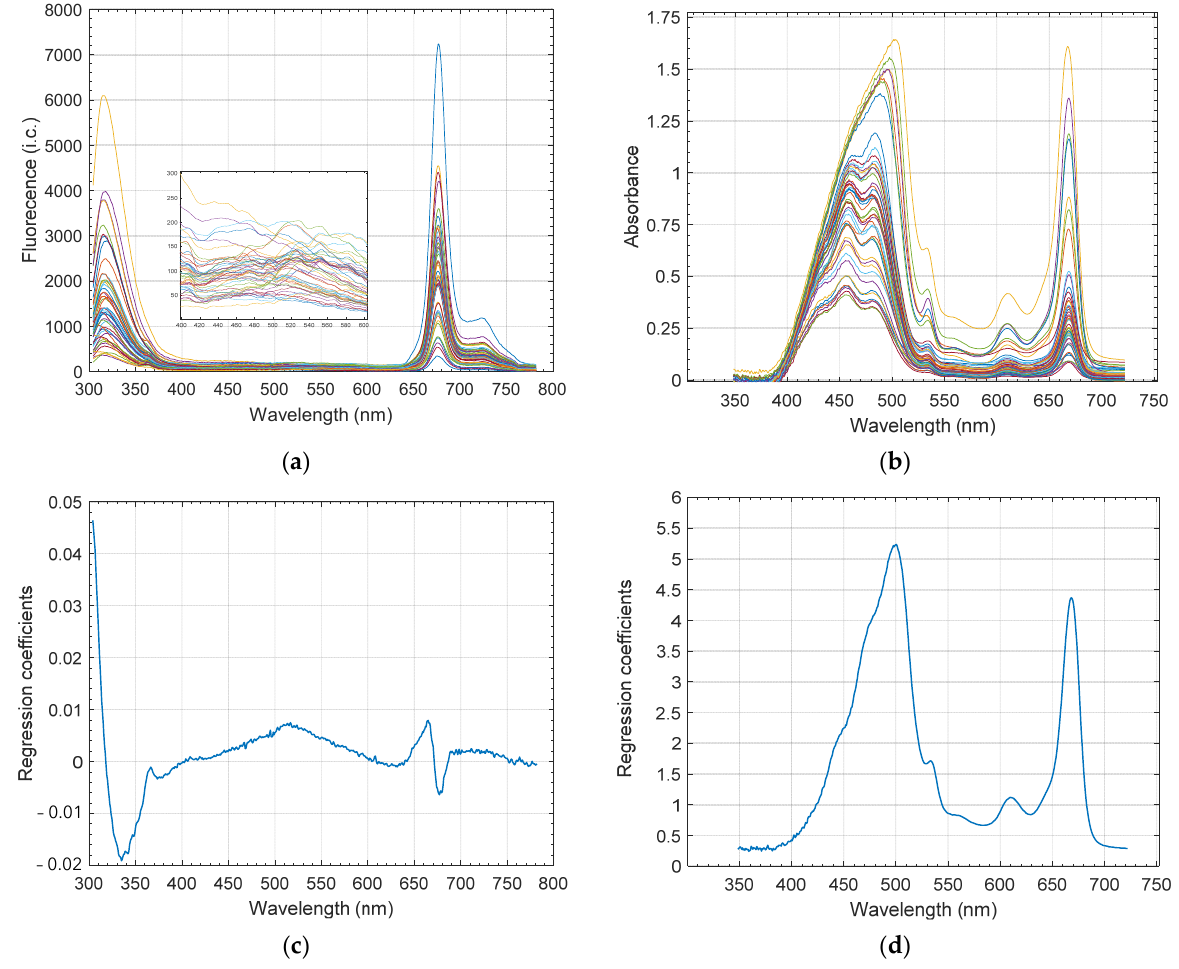
Figure 2. ( a ) Fluorescence emission spectra of EVOO at 270 nm excitation wavelength ( n = 48 samples); ( b ) absorbance spectra for the same samples; ( c ) regression coefficients of the SO-PLS multiblock model for the fluorescence raw data block (three LVs); ( d ) regression coefficients of the SO-PLS multiblock model for the absorbance raw data block (one LV).